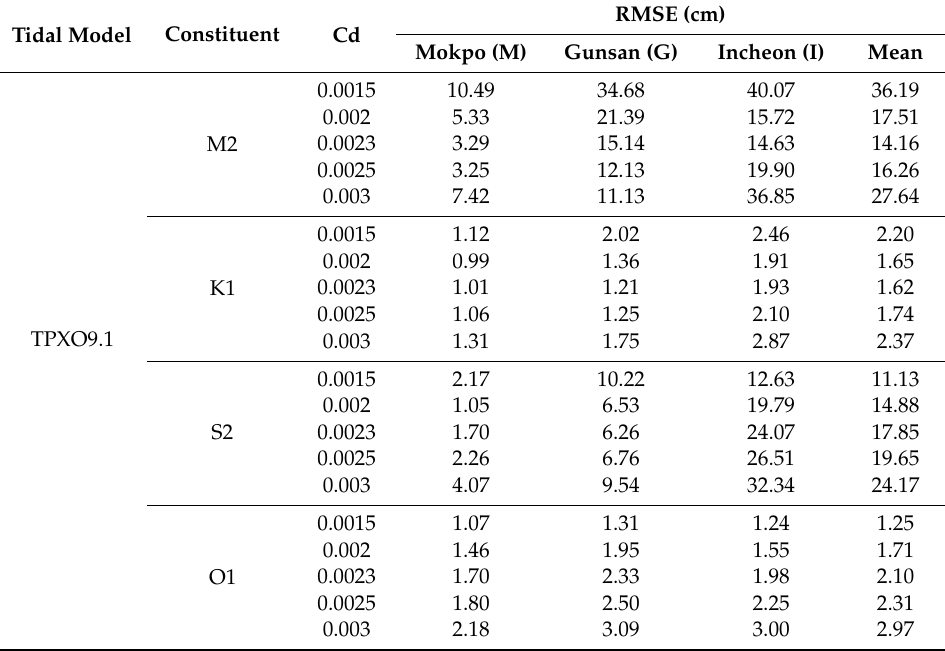
Table A4. RMSE results obtained from uniform roughness bottom for TPXO9.1.